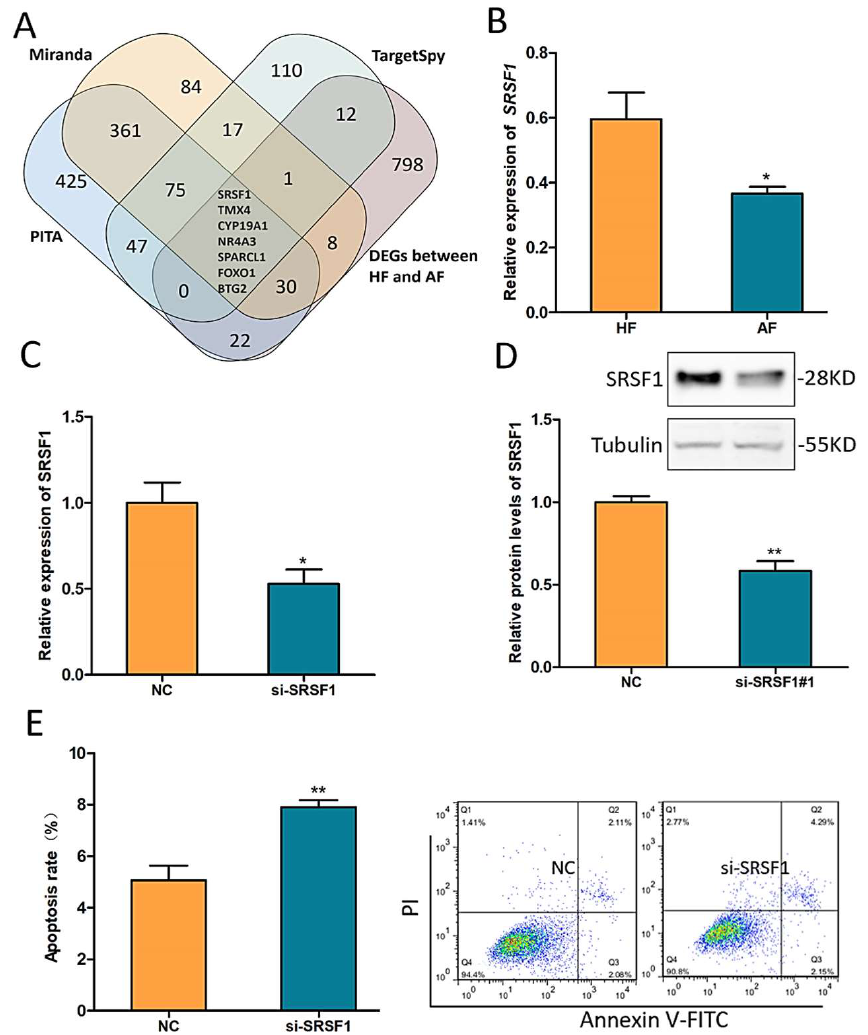
Figure 4. SRSF1 resists GC apoptosis and follicular atresia. ( A ) Venn diagram of the DEGs (differ- entially expressed genes) between HFs and AFs and miR−9820−5p target genes predicted by PITA, Miranda, and TargetSpy. ( B ) Differentially expressed SRSF1 in HFs and AFs detected by qRT−PCR. ( C,D ) Effective knockdown of SRSF1 by si−SRSF1 qRT−PCR and western blotting (WB). ( E ) The shift of GC apoptosis rates after SRSF1 knockdown was detected by flow cytometry. Data are expressed as the mean ± SEM of three experiments; * p < 0.05, ** p < 0.01.